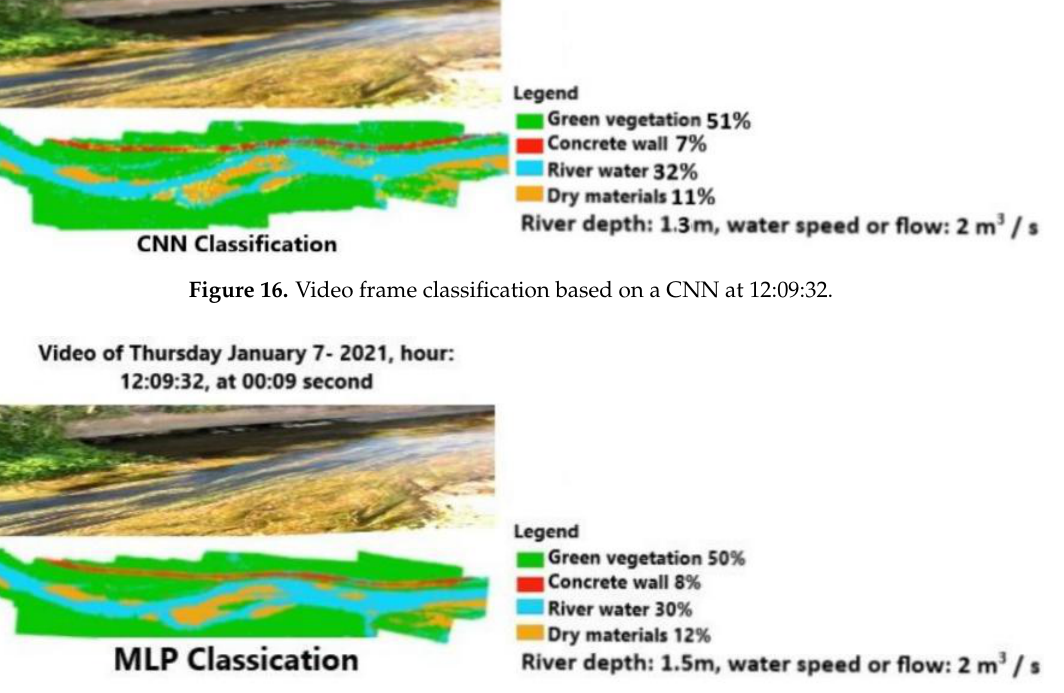
Figure 17. Video frame classification based on an MLP at 12:09:32.